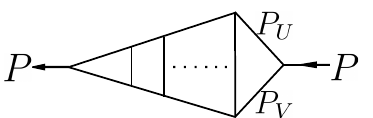
Figure 2. The ladder diagram. Figure 3. The ladder diagram of the inte- grated